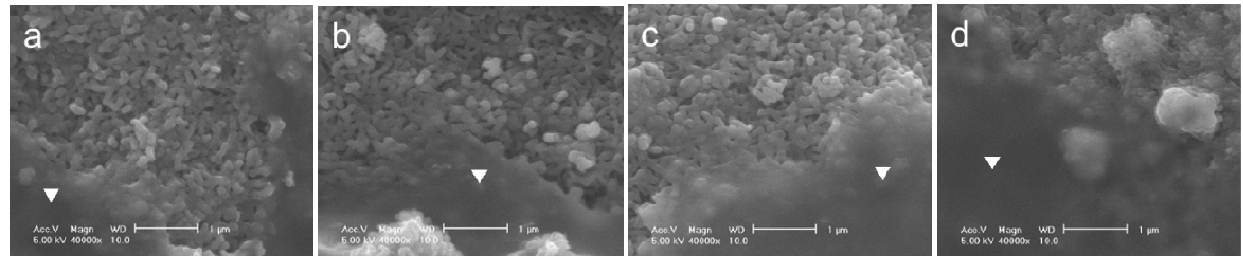
Figure 4. SEM images of the FGF-2-apatite composite layers after the Scotch ® tape detachment test on ( a ) 25F0.5; ( b ) 25F1.0; ( c ) 25F2.0; and ( d ) 37F4.0. Glue on a smooth surface is marked with an inverted triangle.